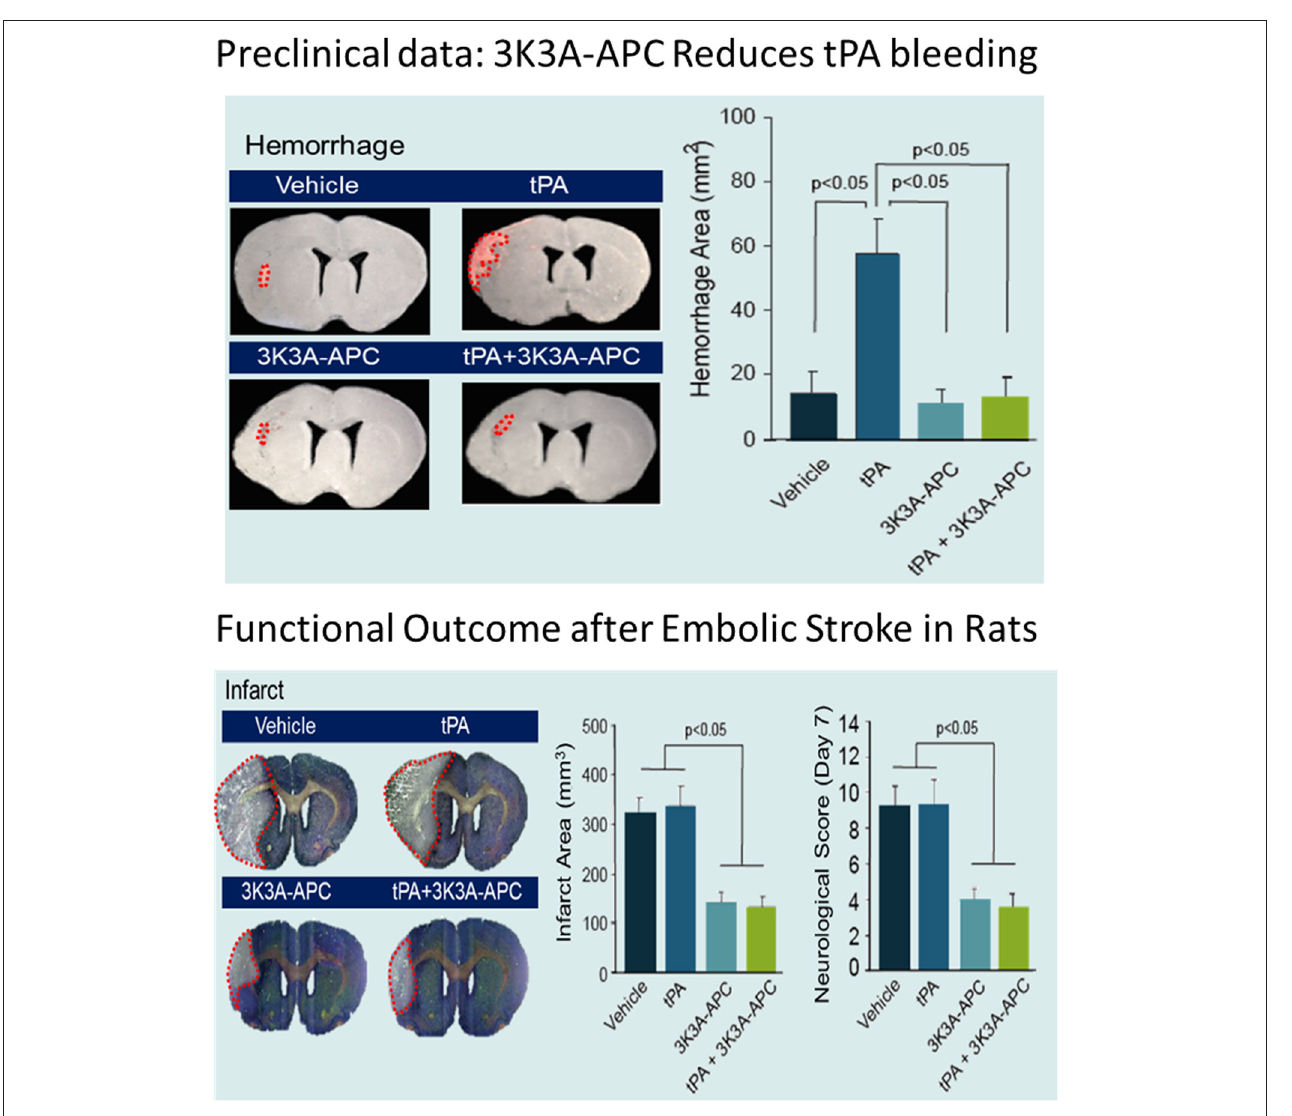
FIGURE 4 | Effects of 3K3A-APC and 3K3A-APC combined with tPA on hemorrhage (upper panel) and neuropathological (hematoxylin and eosin staining; infarct volume) and neurological (neurological score) outcomes (lower panel) in young male spontaneously hypertensive rats within 7 days after embolic stroke. APC, activated protein C; SD, standard deviation; tPA, tissue plasminogen activator. Reprinted from Stroke, vol. 44(12), Wang et al. (56) activated protein C analog protects from ischemic stroke and extends the therapeutic window of tissue-type plasminogen activator in aged female mice and hypertensive rats, 3529–3536, 2013, with permission from Wolters Kluwer Health, Inc. 3K3A-APC and tPA were administered 4h after embolic stroke. 3K3A-APC was administered for 3 consecutive days afterward. Mean + SD, N = 8–9 rats per group.